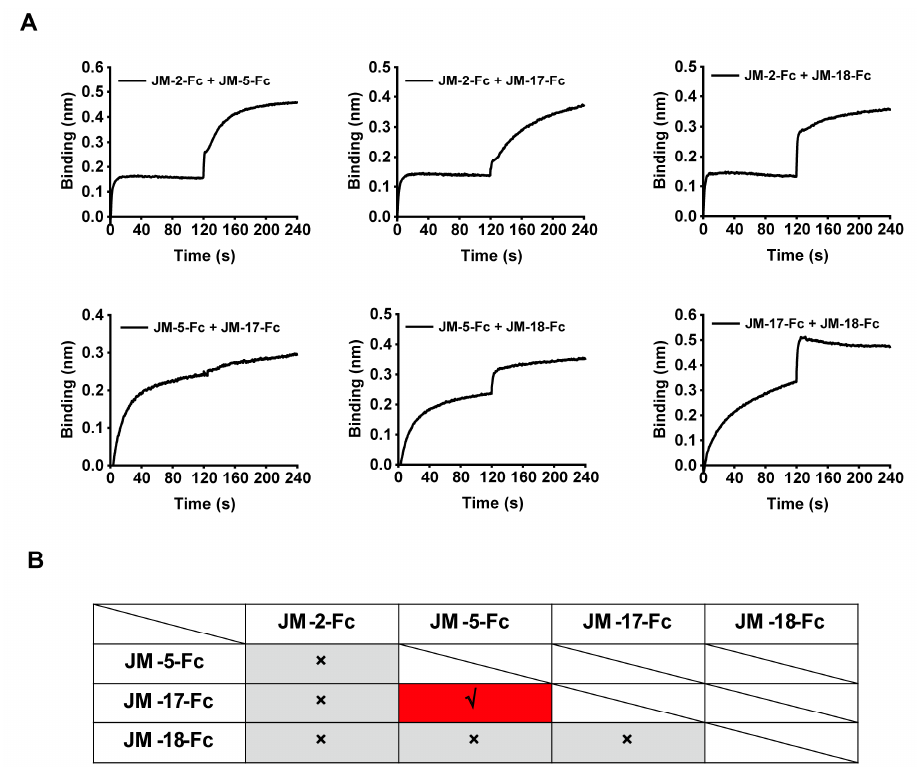
Figure 5. Epitope competition results of the four identified VNAR-Fc fusions by BLI. ( A ) The epitope competition determined by the binding signal transition of two VNAR-Fc fusions. ( B ) The summarized epitope competition results of VNAR-Fc fusions. The red and gray colors indicate competitive and noncompetitive relationships, respectively.